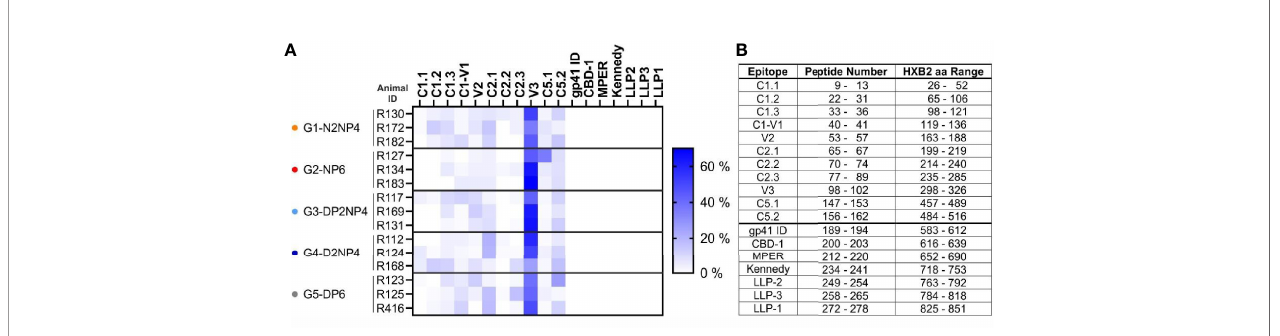
FIGURE 9 | Linear epitope mapping. (A) Week 26 sera of the indicated macaques were analyzed for antibodies binding to linear Env epitopes on a peptide array. Week 0 responses were subtracted. Reactivity of IgG antibodies to subregions of Env is indicated by color intensity (scale on the right) for each animal analyzed. Binding to each subregion of Env is given in percent of the summed-up binding of each animal to all subregions. (B) Peptide numbers in the array library and aa range based on HXB2 numbering for